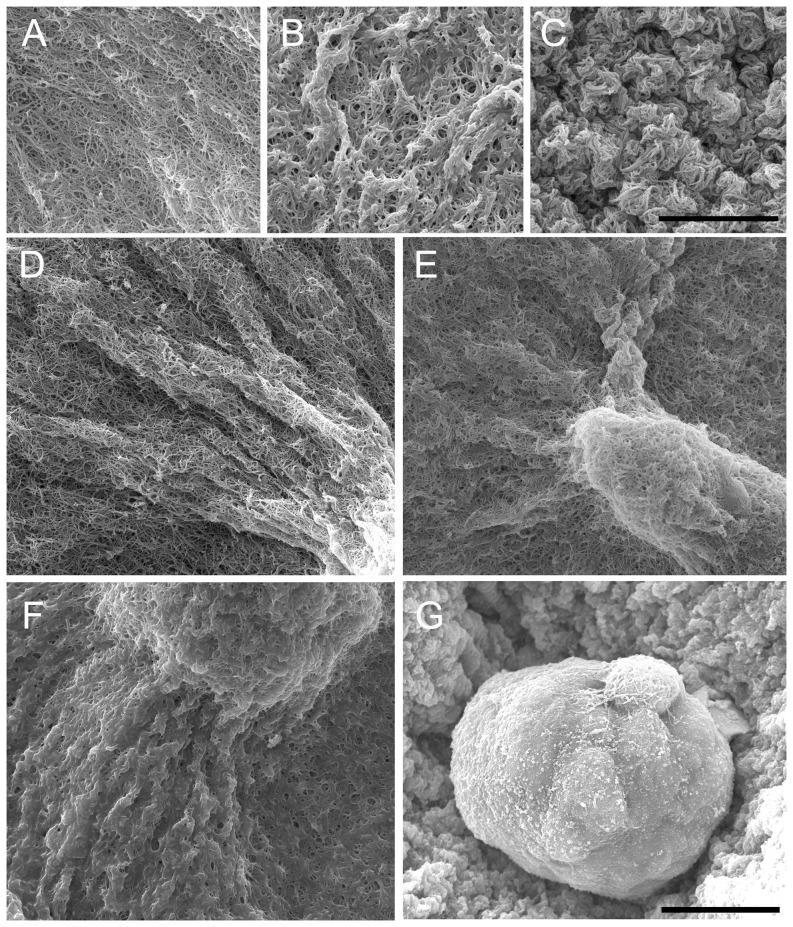
SEM images of epithelial structures and their matrix at day-5.(A) Collagen fibers are clearly distinguished in a collagen-only matrix. (B) The addition of 5% Matrigel results in a globular rather than (A) fibrilar matrix. (C) The globular matrix is more compact in 50% Matrigel. (D) Tubular extensions are observed at the tip of a duct in a collagen-only matrix. (E) Ductal and (F) acinar structures in 5% Matrigel; Matrigel forms a localized coating in areas surrounding the acinus. (G) An acinus grown in 50% Matrigel; collagen fibers are not visible. Scale bar, 10 μm in A to C and 15 μm in D to G.